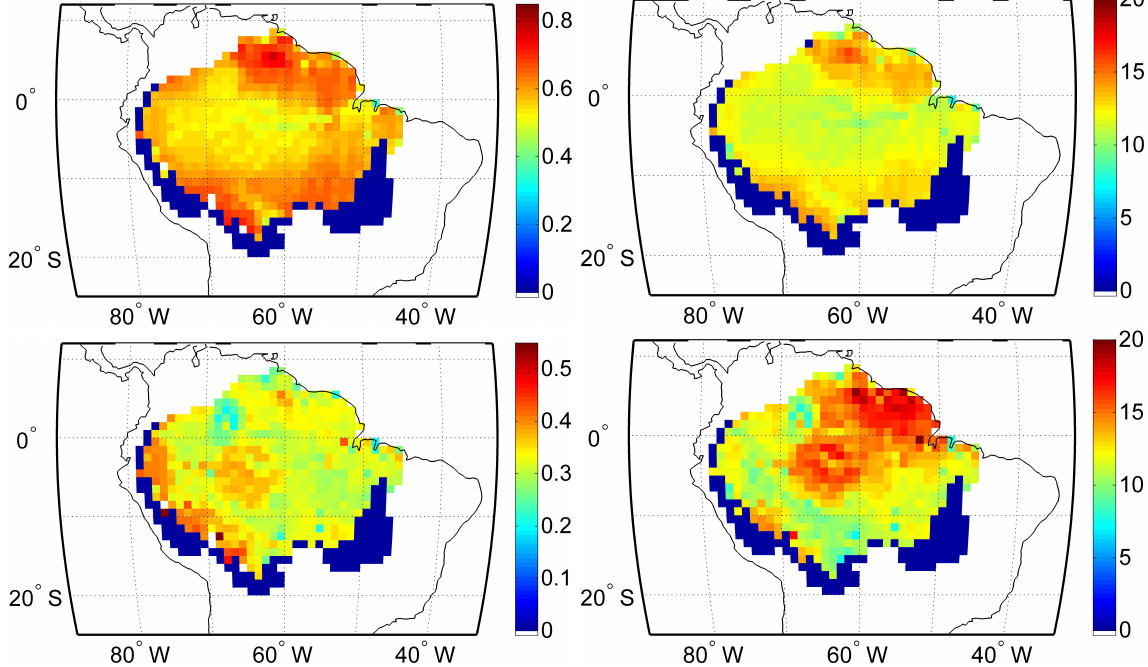
Fig. 8. Woody above-ground net primary productivity (left column, NPP w [kg-Cm − 2 yr − 1 ]) and the woody above-ground live biomass (right column, AGB w [kg-Cm − 2 ]). The first row presents the regional simulation under the control scenario (CA). The second row presents the IBIS-simulated map based on the upscaled parameterization